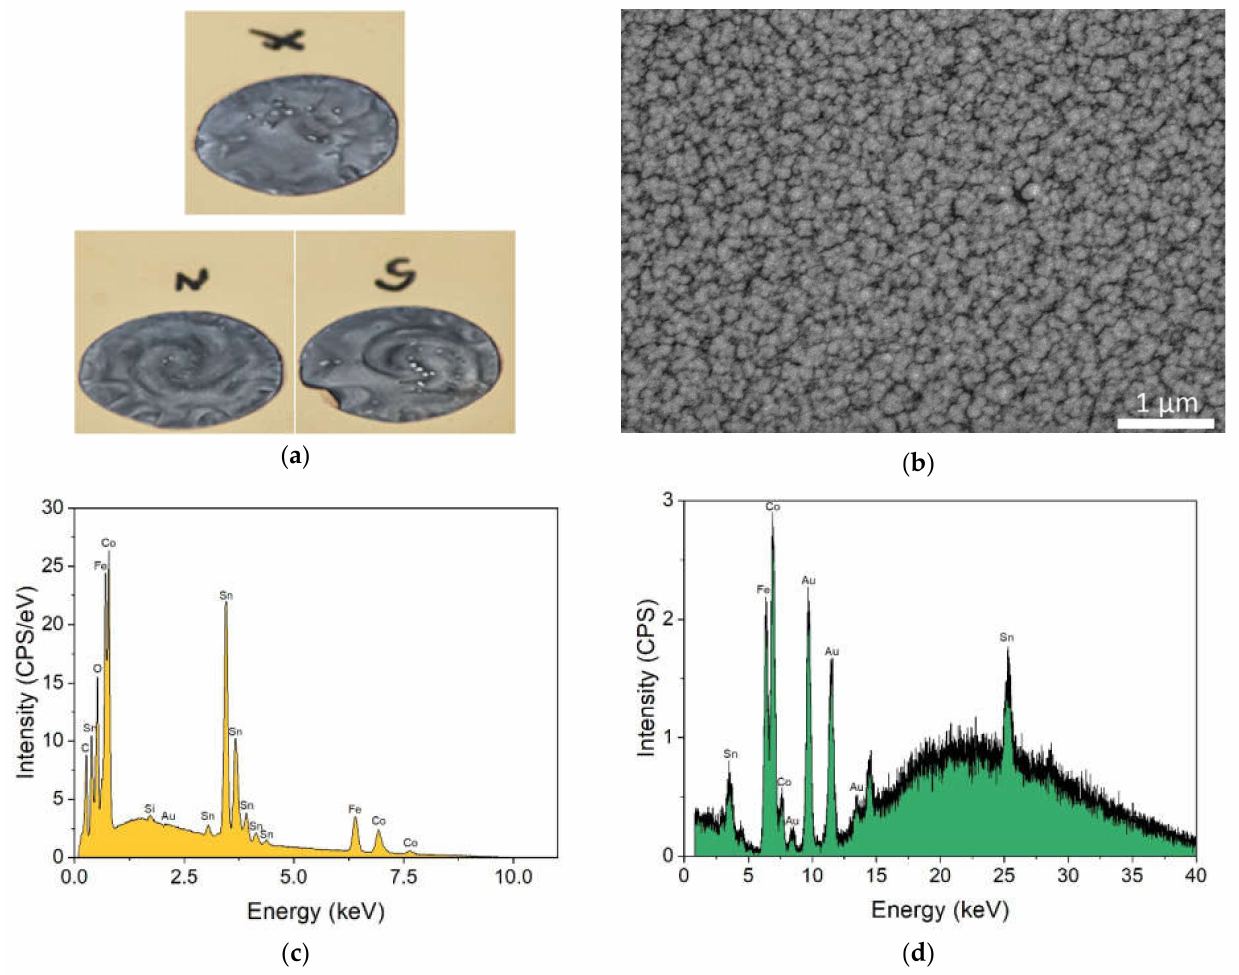
Figure 3. ( a ) Photos of the obtained films. The contrast was increased to make evident the opposite handedness of the samples obtained with the opposite magnetic field; ( b ) SEM, ( c ) EDS, and ( d ) XRF analysis of the deposit obtained without the